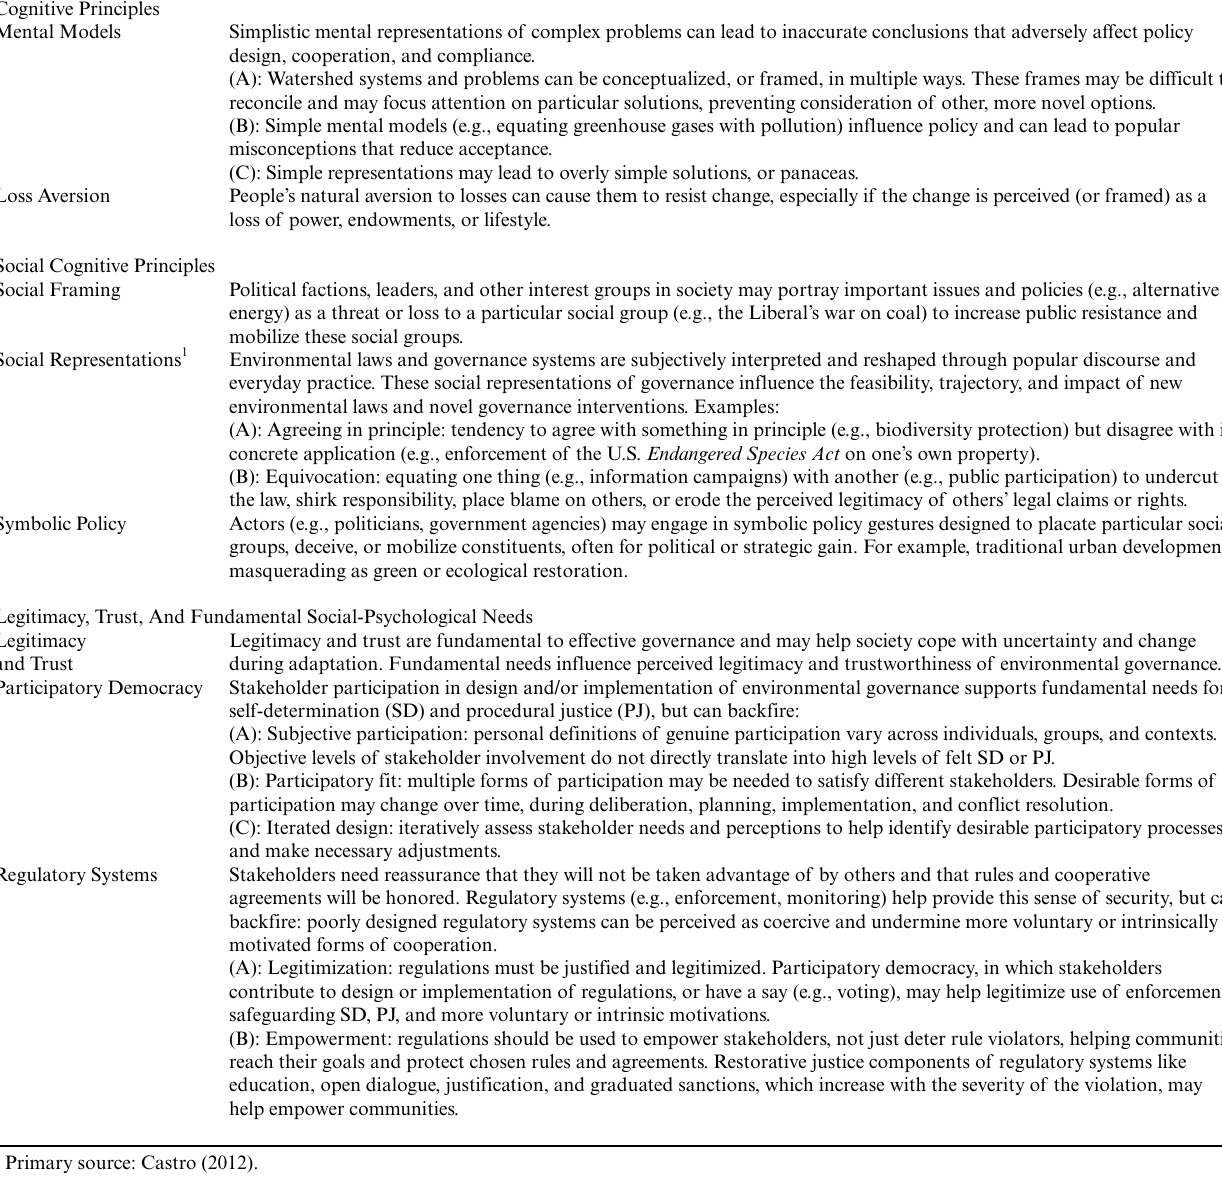
Table 1 . Cognitive and Social Cognitive